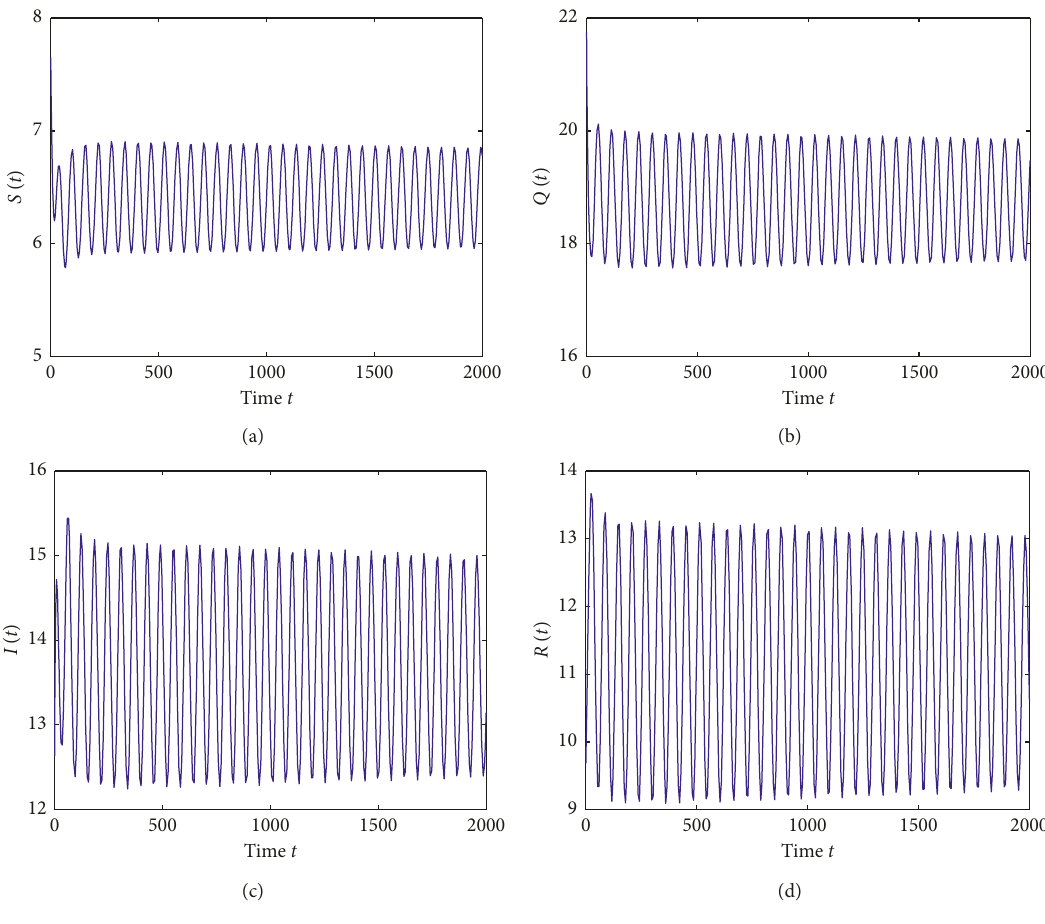
Figure 5: Waveform plots of system (65) with τ